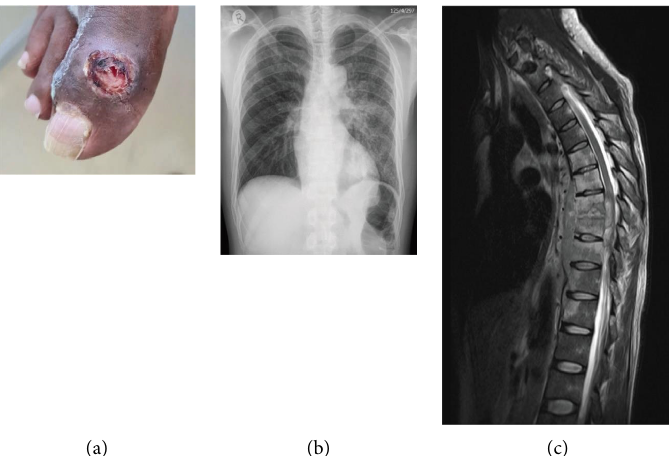
Figure 1: (a) Right hallux non-healing ulcer, (b) chest radiograph, and (c) magnetic resonance imaging (MRI) of the thoracic